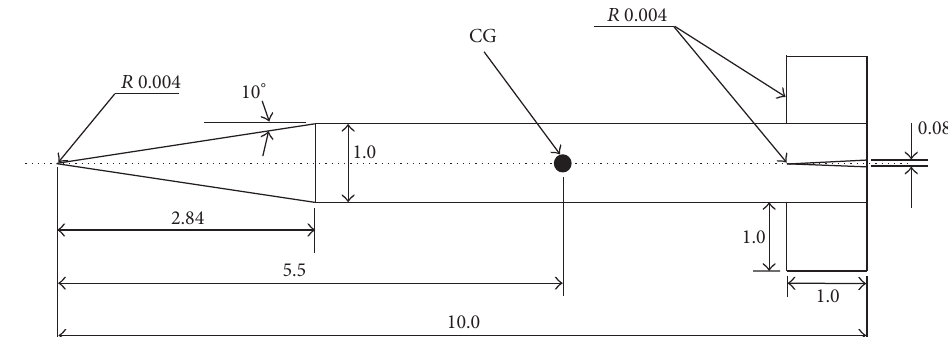
Figure 1: Schematic of the basic finned configuration (in calibers; 1cal. = 0.03 m).